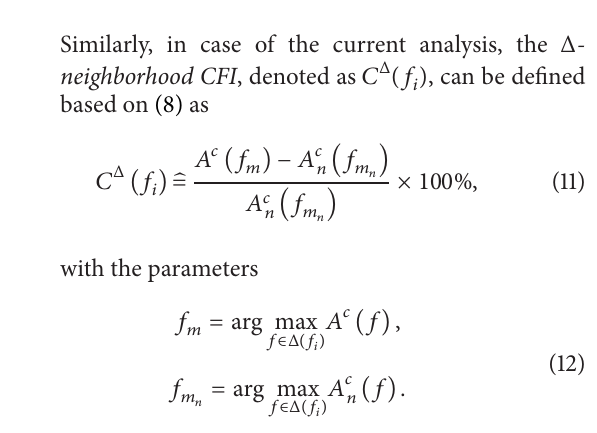
Table 5: Calculated 𝐶 Δ (𝑓 𝑖 ) s within [ 0, 540 ] Hz, 50 Hz motor input, free load condition, and current